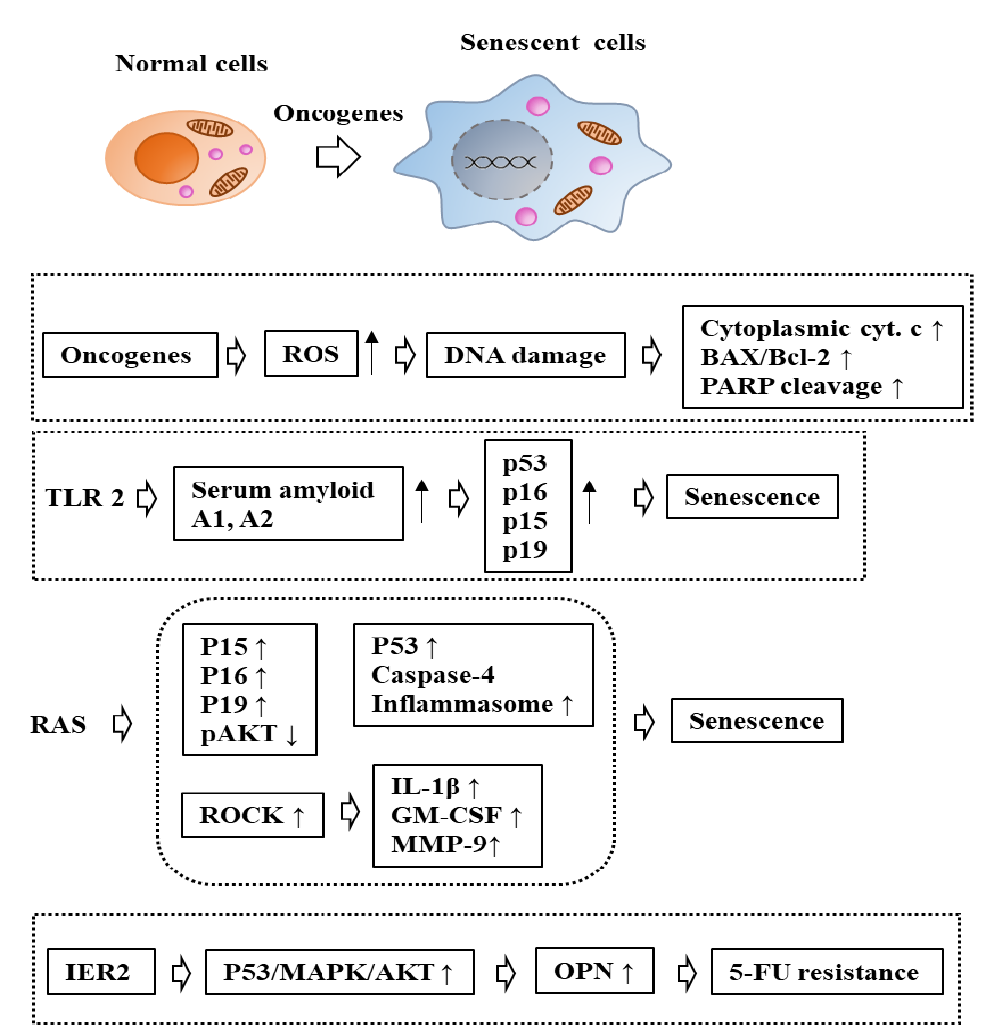
Figure 3. Mechanism of OIS. ↑ indicates an increase in expression/activity. ↓ indicates a decrease in expression/activity. The hollow arrows denote the direction of the reaction. OPN is osteopontin. TLR2 is toll-like receptor 2, and IER2 is immediate early